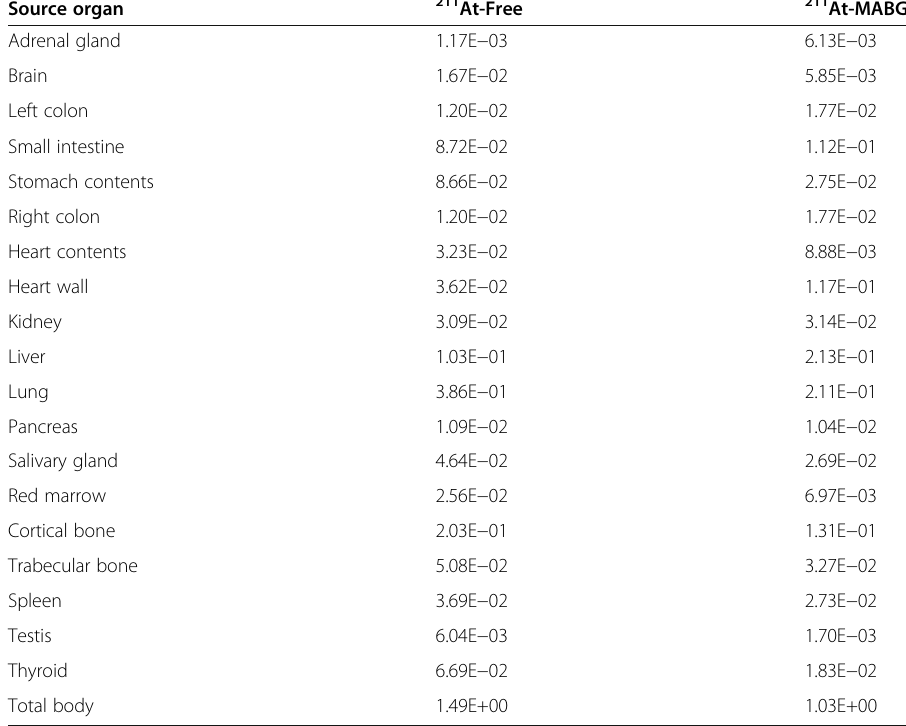
Table 2 Time-integrated activity coefficient (Bq-h/Bq) for input to OLINDA/EXM version 2.0 for adult male model calculated using OLINDA/EXM version 1.1 for free 211 At and 211 At-MABG in the main target organs. It was calculated by extrapolation from the distribution data of mice Source organ 211 At-Free 211